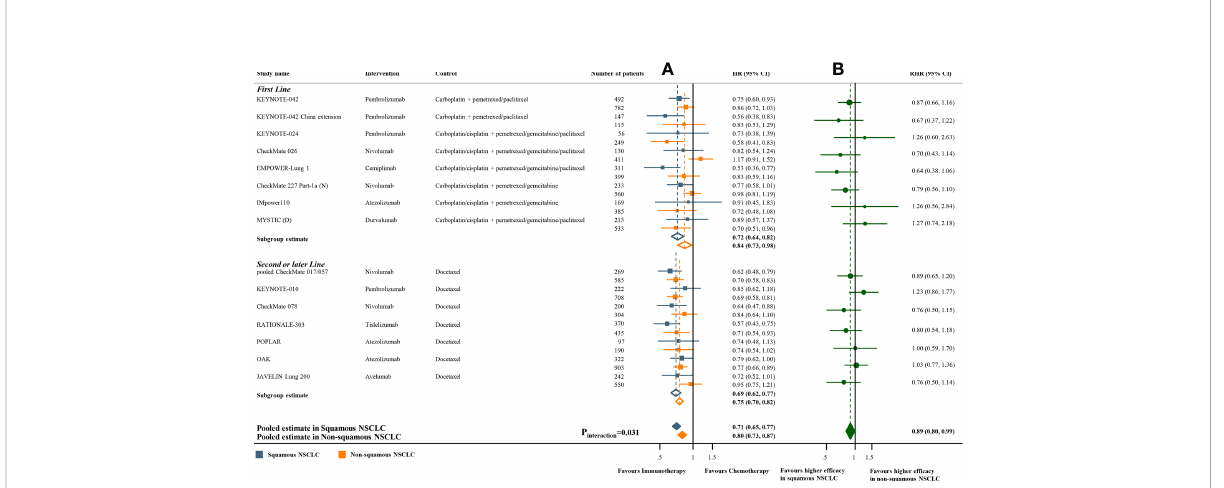
FIGURE 2 Overall survival bene fi ts of ICI monotherapy compared with chemotherapy in studies with paired subgroups. (A) HRs according to histology. (B) Trial-speci fi c ratios of the HR in SQ-NSCLC to the HR in non-SQ-NSCLC. ICI, immune checkpoint inhibitor; HR, hazard ratio; RHR, ratios of the HRs; CI, con fi dence